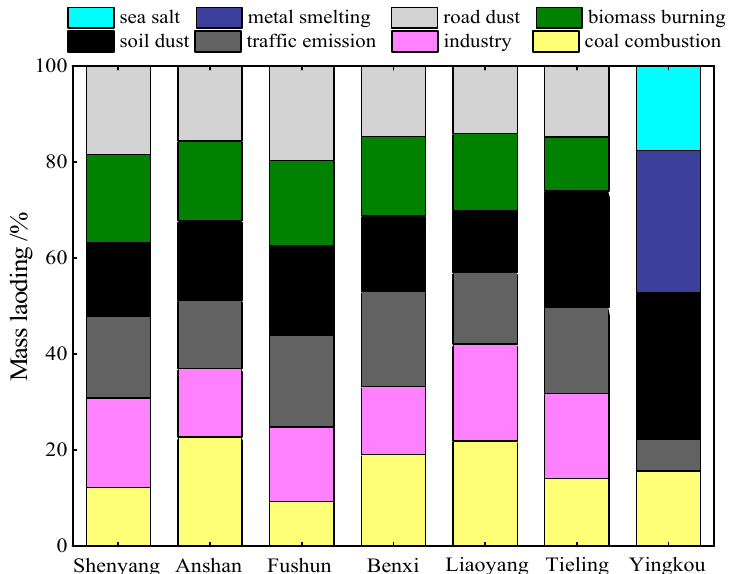
Figure 5. Contribution percentage of the identified sources to PM 2.5 at seven cities; while the first six cities share the same source, Yingkou is different from them.